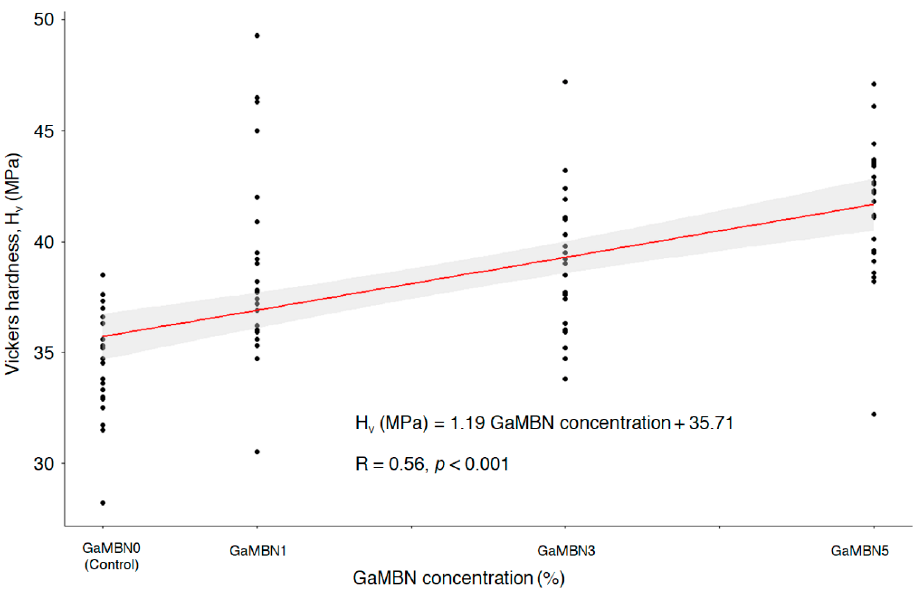
Figure 7. Correlation between Vickers microhardness and the GaMBN concentration of the resin disk (R = 0.56; p < 0.001).